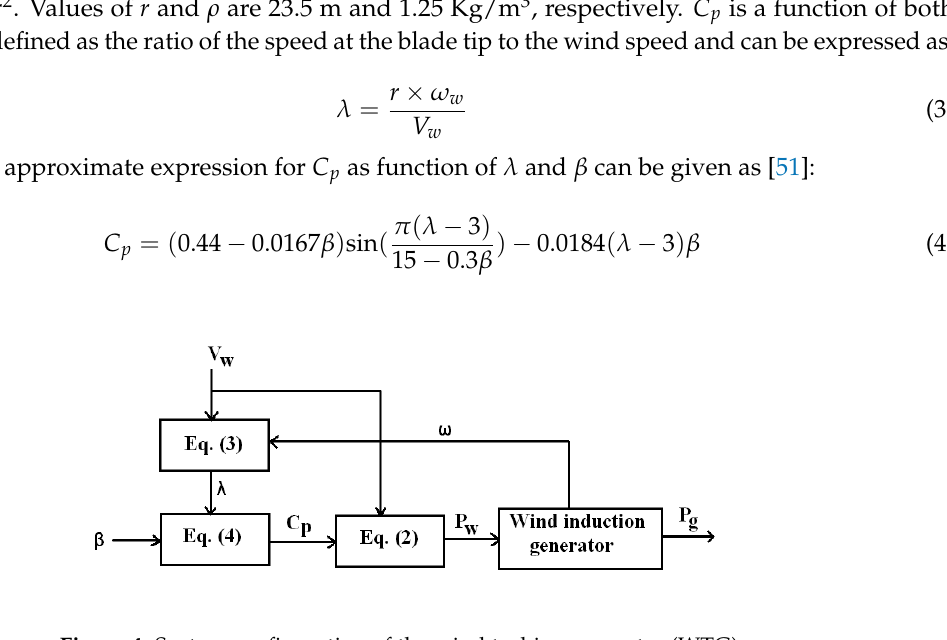
Figure 4. System configuration of the wind turbine generator